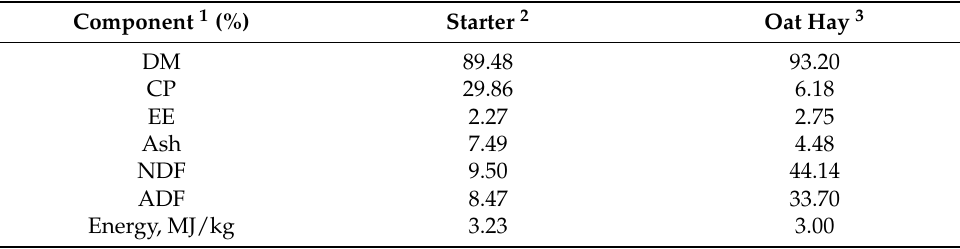
Table 1. Chemical composition (as % of DM) of starter feed and oat